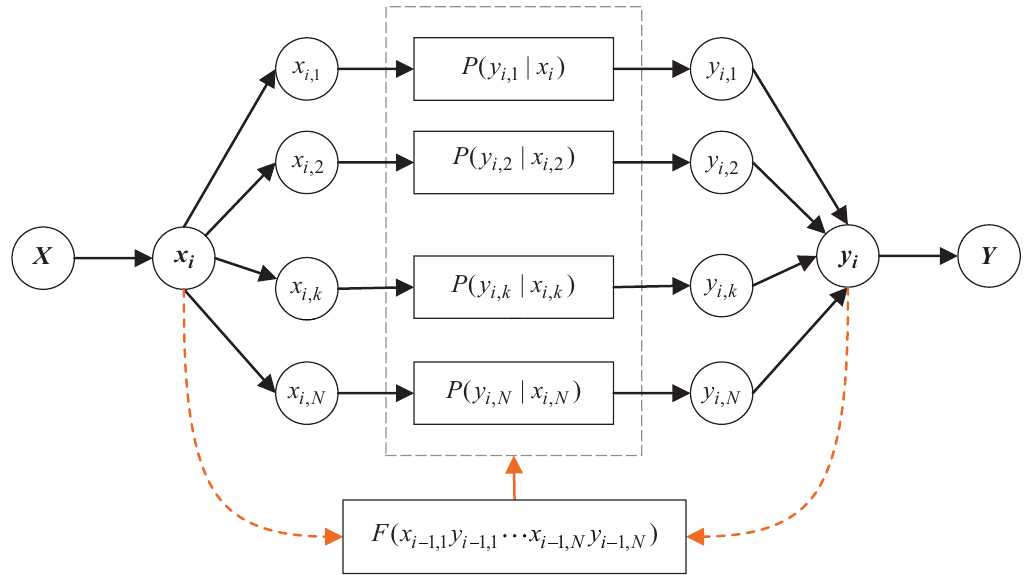
Figure 7. Information transmission in the DHR with the feedback memory-elimination construction channel [12]